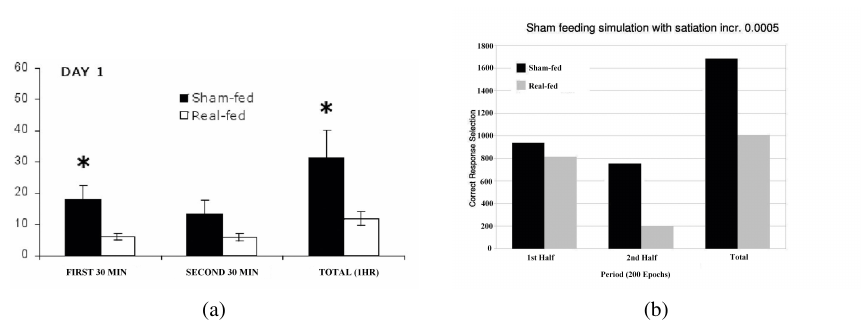
Figure 4. (Simulation) (a) Sucrose intake measurements (in ml) during the first hour of feeding of sham-feeding and real-feeding rats with access to sugar. The asterisks indicate differences between groups ( P > 0:05 )